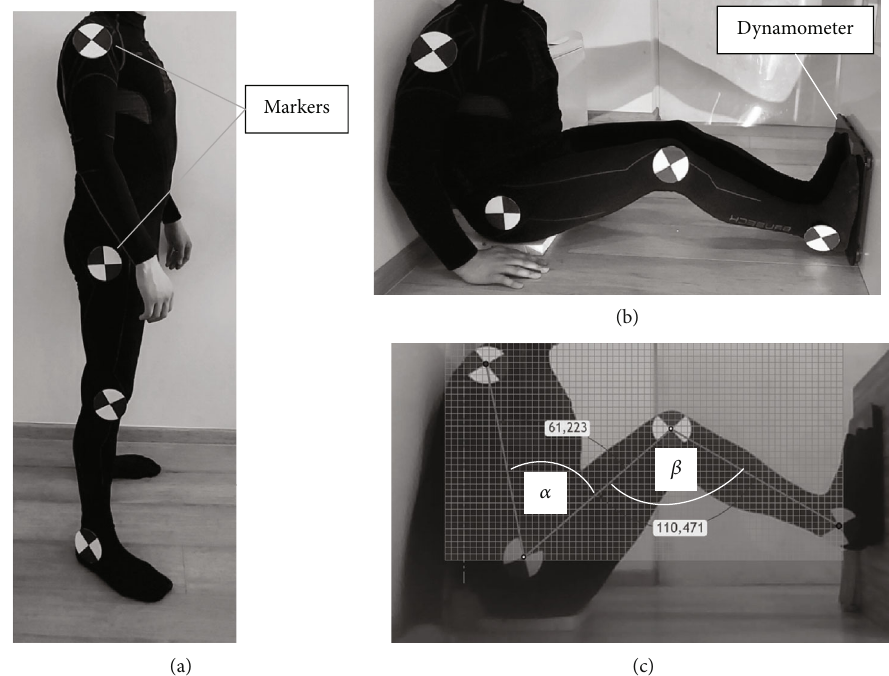
Figure 8: Pictures from tests: (a) position of markers on a man, (b) illustrative photo of the test and the position of the dynamometer, and (c) position C7 (see Table 1) when measuring force.